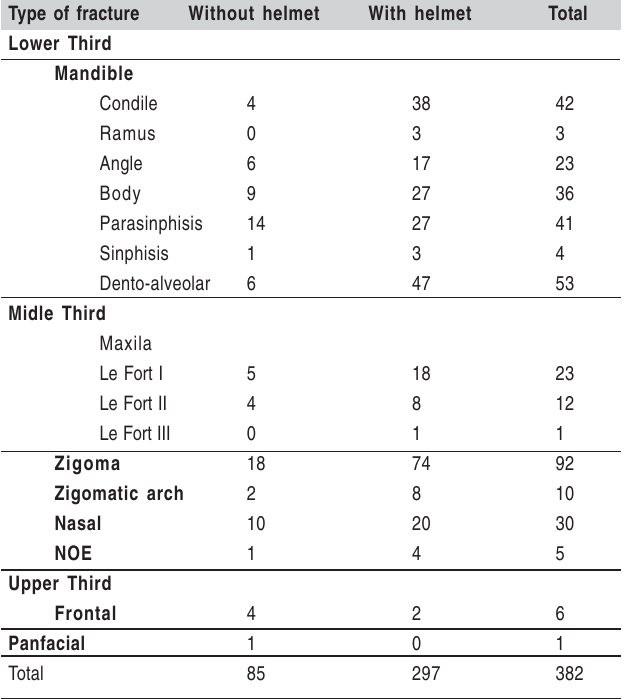
Table 4. Distribution of maxillofacial fractures according to anatomic sites and the use of